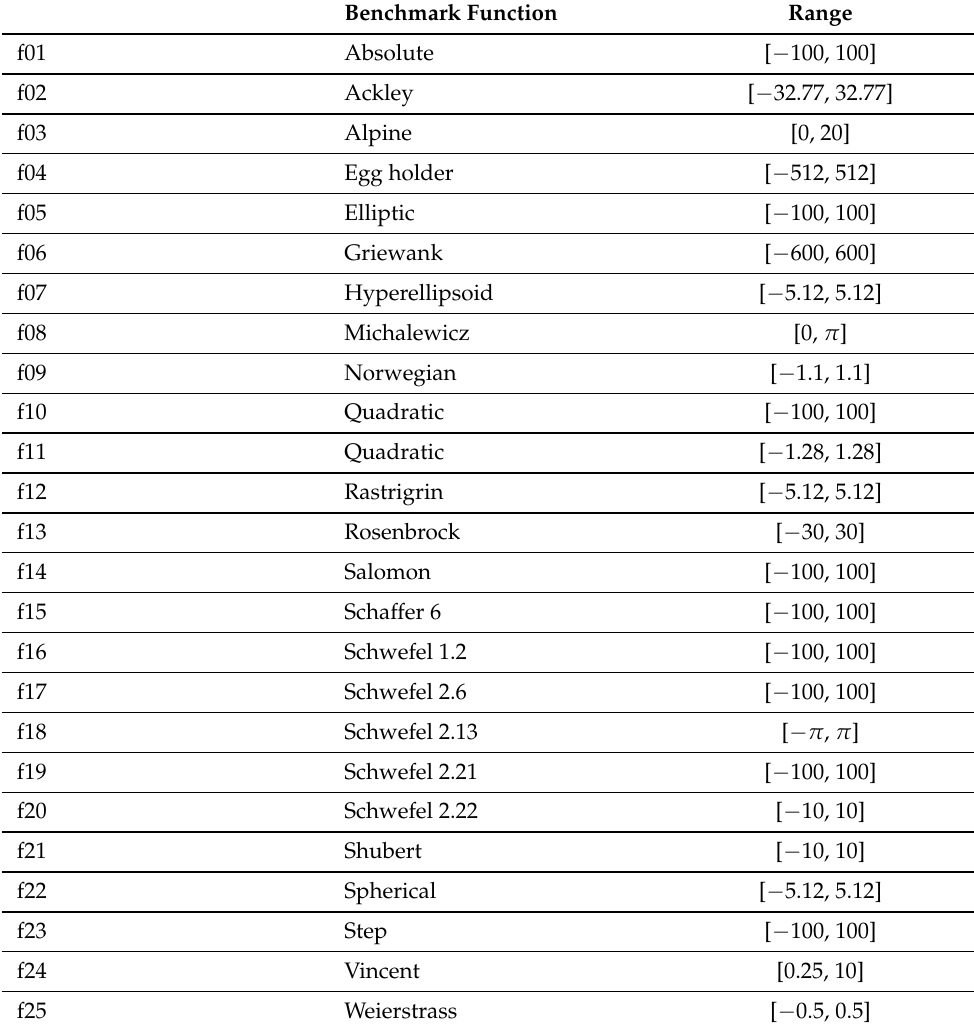
Table 2. Benchmark functions.